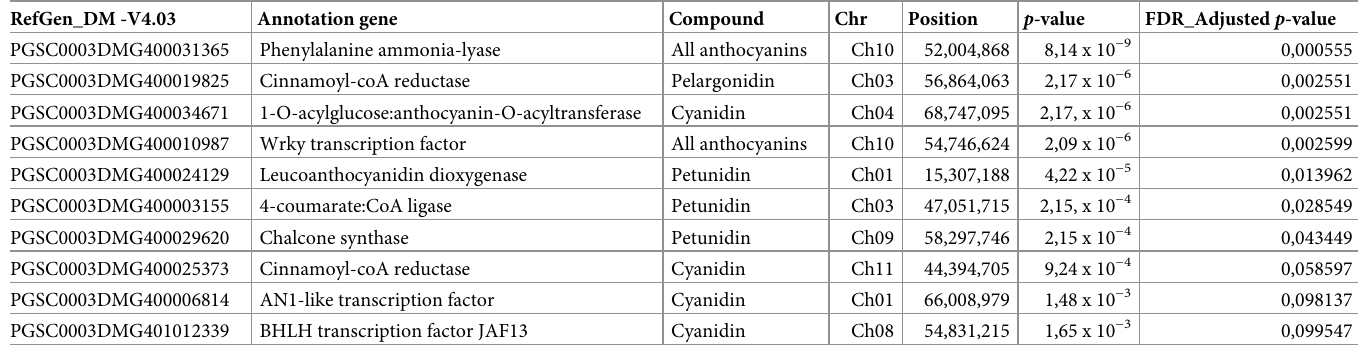
association between the content of five anthocyanins in a subset of pre-selected candidate anthocyanin homologs retrieved from the literature and databases (S4 Table). The analysis involved recalculating trait associations among the five anthocyanins and the genotypes at SNP markers located within ± 100 Kb of the 108 anthocyanin homologs (S5 Table). Nineteen SNPs were statistically significant at 0.1 FDR for at least one of five anthocyanin compounds (S6 Table). These 19 significant SNP markers were located into 10 of the pre-selected